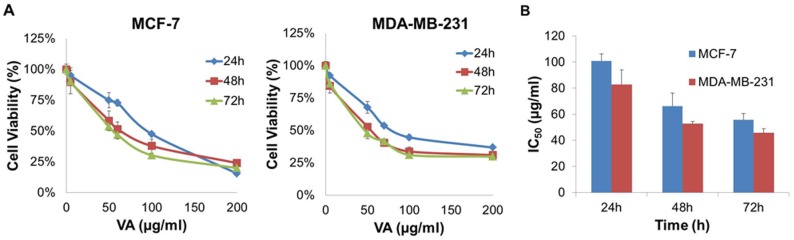
Anti-proliferative effect of VA on human breast cancer cells.(A) Dose-response curves of VA treatment in MCF-7 and MDA-MB-231 cells. Cells were cultured in 96-well plates and treated with indicated concentrations of VA (0–200 µg/ml) for 24, 48, and 72 h respectively. Cell viability was measured by MTT assay. Data represent the mean ± S.E.M. of three independent experiments. Statistical differences were analyzed with Student's t-test. (B) Comparison of IC50 of VA in MCF-7 and MDA-MB-231 cells at different time points. Values were derived from the graph of growth inhibition against drug concentration (µg/ml) from MTT assay. Data represent the mean ± S.E.M. of three independent experiments.